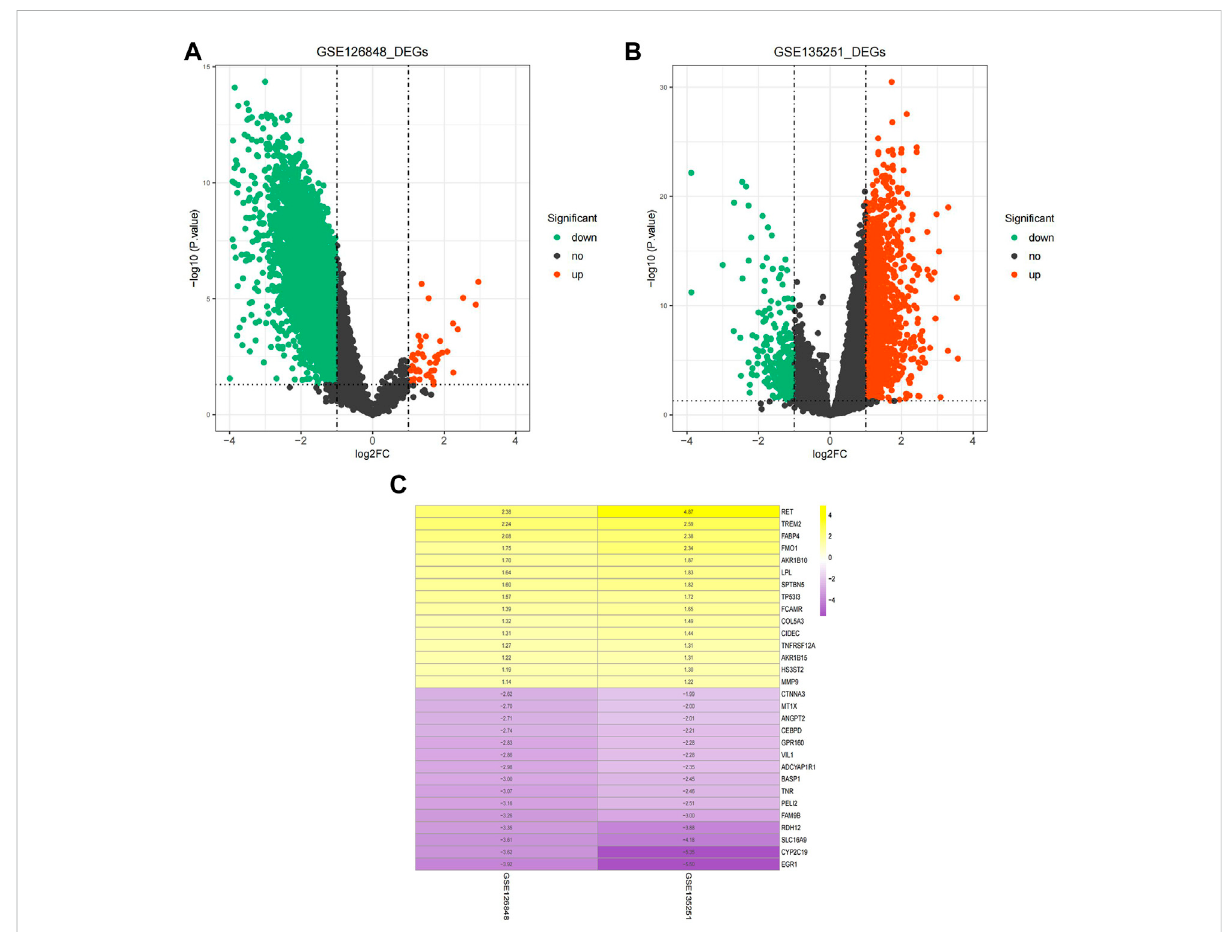
FIGURE 1 Identi fi cation of DEGs. (A) Volcano plot of DEGs in the GSE126848 dataset. (B) Volcano plot of DEGs in the GSE135251 dataset. The abscissa of log2FC is the fold change (NAFLD/normal), and the ordinate is the credibility-log10 ( p-value ). Each dot in the volcano plot indicates a gene, and the red and green dots indicate signi fi cant DEGs. Red dots indicate that gene expression is upregulated in NAFLD samples, and green dots indicate that gene expression is downregulated in NAFLD samples. Dashed lines of abscissa and ordinate indicate the absolute log FC threshold of 1 and the p-value threshold of 0.05, respectively. (C) Heatmap of upregulated and downregulated DEGs. Yellow indicates upregulated DEGs, purple indicates downregulated DEGs. The darker the colour is, the more signi fi cant the upregulation and